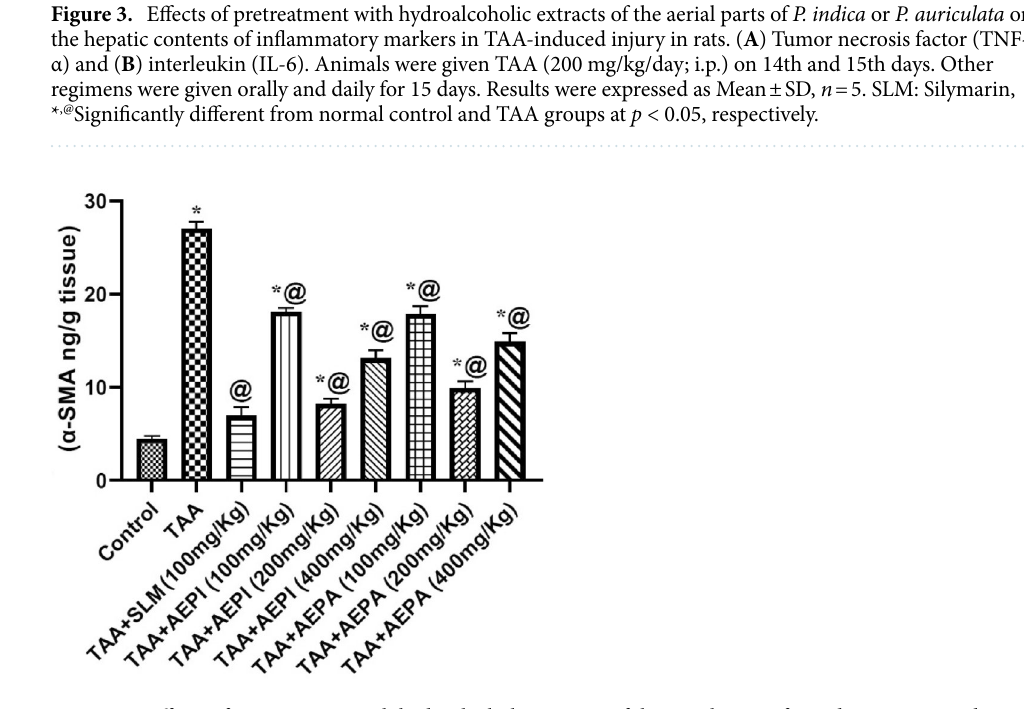
Figure 4. Effects of pretreatment with hydroalcoholic extracts of the aerial parts of P. indica or P. auriculata on the hepatic α-SMA in TAA-induced liver injury in rats. Animals were given TAA (200 mg/kg/day; i.p.) on 14th and 15th days. Other regimens were given orally and daily for 15 days. Results were expressed as Mean ± SD, n = 5. SLM: Silymarin, * ,@ Significantly different from normal control and TAA groups at p < 0.05,